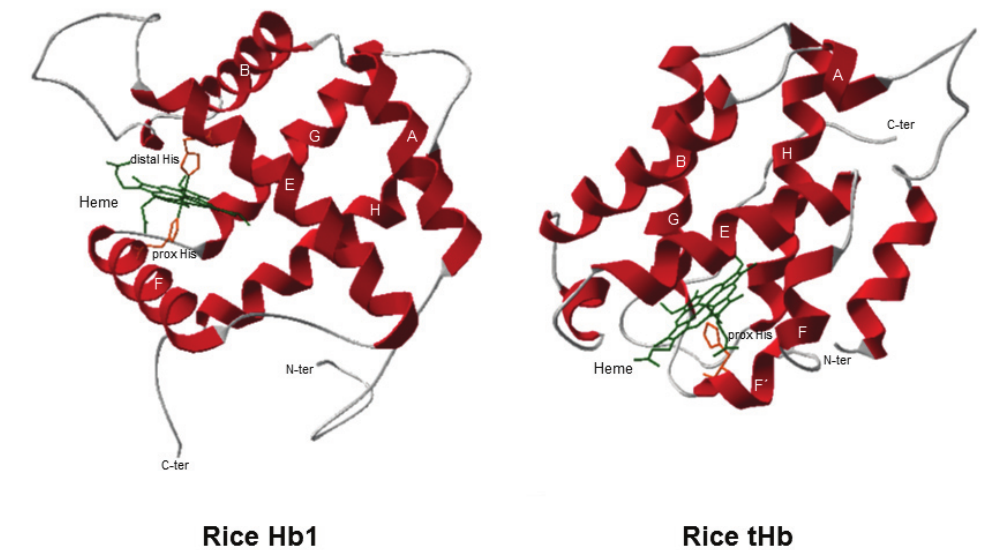
Figure 4. Crystal structure of rice Hb1 (PDB ID 1D8U) and predicted structure of rice tHb. The tertiary structure of rice tHb was modeled using the automated mode of the I-Tasser server (http://zhanglab.ccmb.med.umich.edu/I-TASSER/) 131–133 and the crystal structure of the Thermobifida fusca tHb (PDB ID 2BMM) as the structural homologue. Model for the rice tHb is deposited in the Caspur Protein Model Database (http://bioinformatics.cineca.it/PMDB/main.php) under the ID number PM0079484. Helices are indicated with letters A to H.